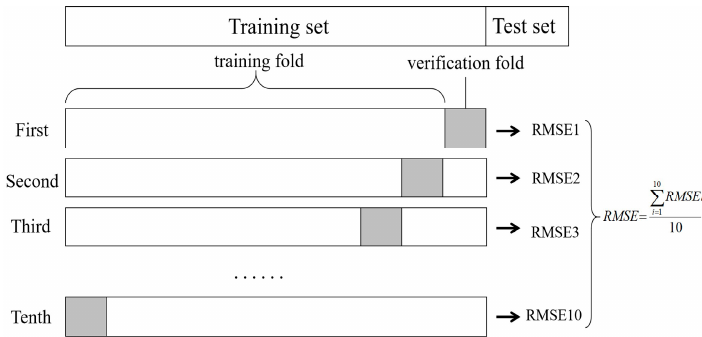
Figure 4. Ten − fold cross validation to determine the number of hidden layer nodes. Figure 4. Ten-fold cross validation to determine the number of hidden layer